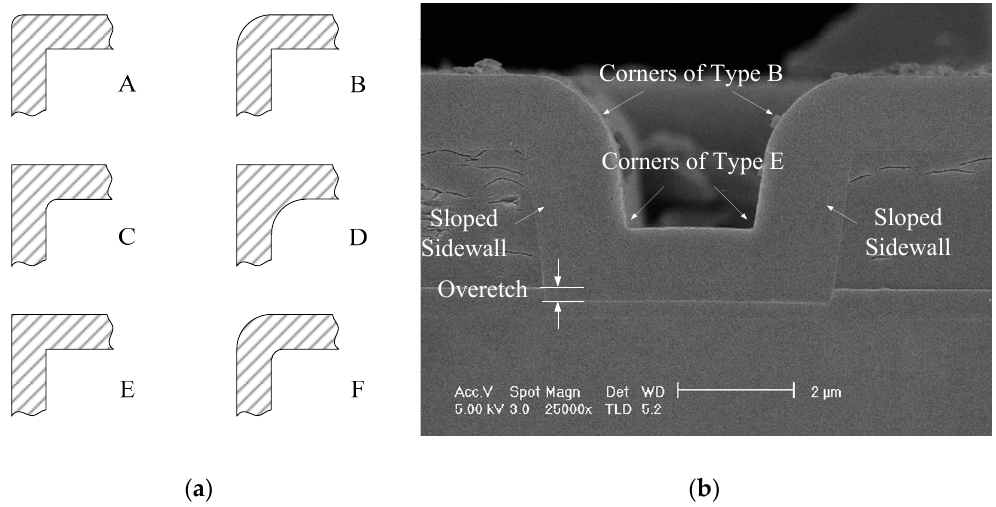
Figure 1. Schematic diagrams of a step structure: ( a ) 3-D view; ( b ) Cross section view.